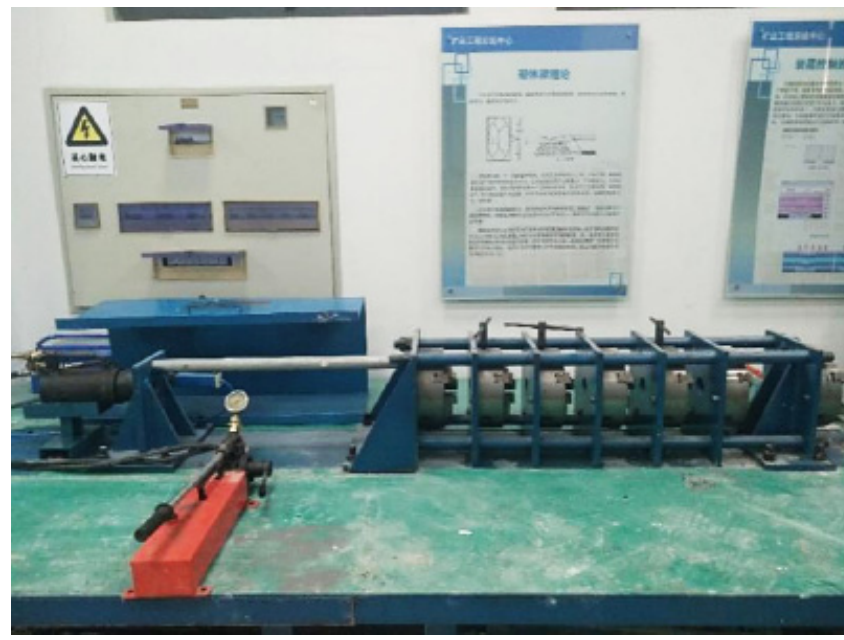
Figure 5. Physical diagram of the experimental device for the prestressed loading of the bolt.